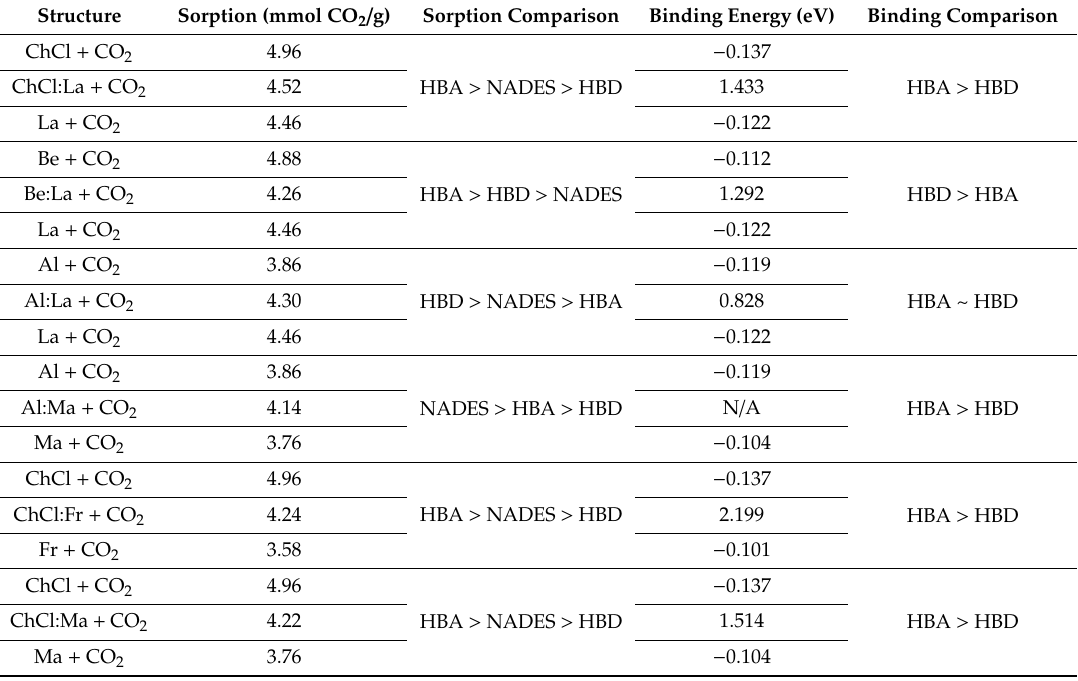
Table 2. Gas sorption data and binding energies